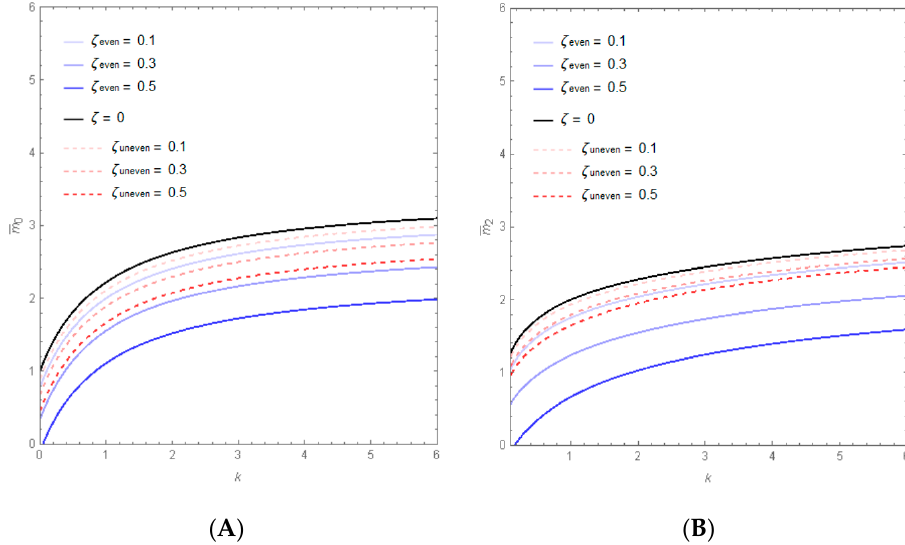
Figure 4. Variations of the dimensionless cross-sectional mass ( A ) and of the rotatory inertia ( B ) of a porous FG nano-beam. The variations are shown in terms of the gradient index of the FG material ( 𝑘 ), varying the porosity volume fraction ( 𝜁 ): even distribution (continuous lines) and uneven distribution (dashed lines).